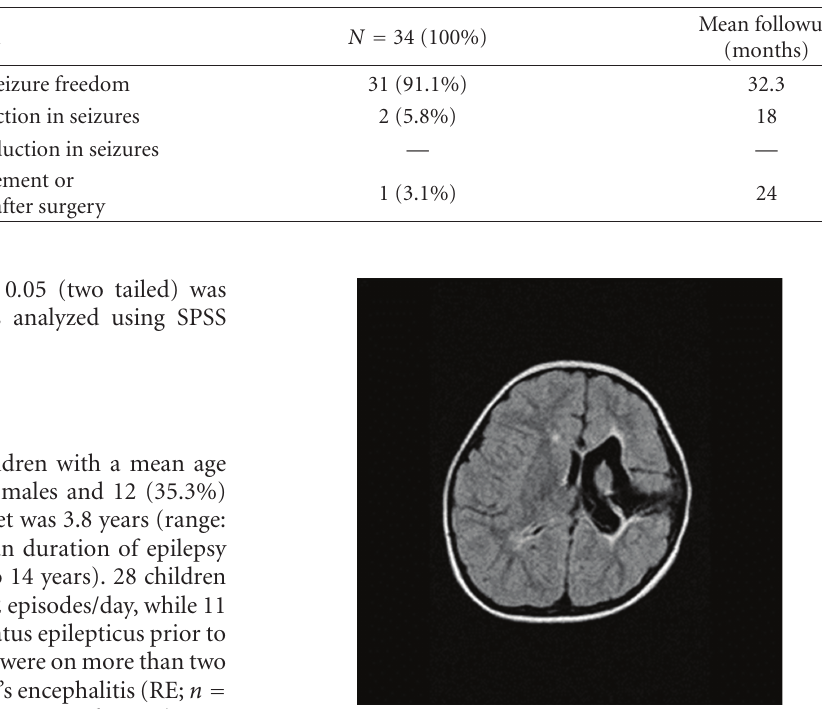
Table 1: Postoperative seizure outcome with followup.